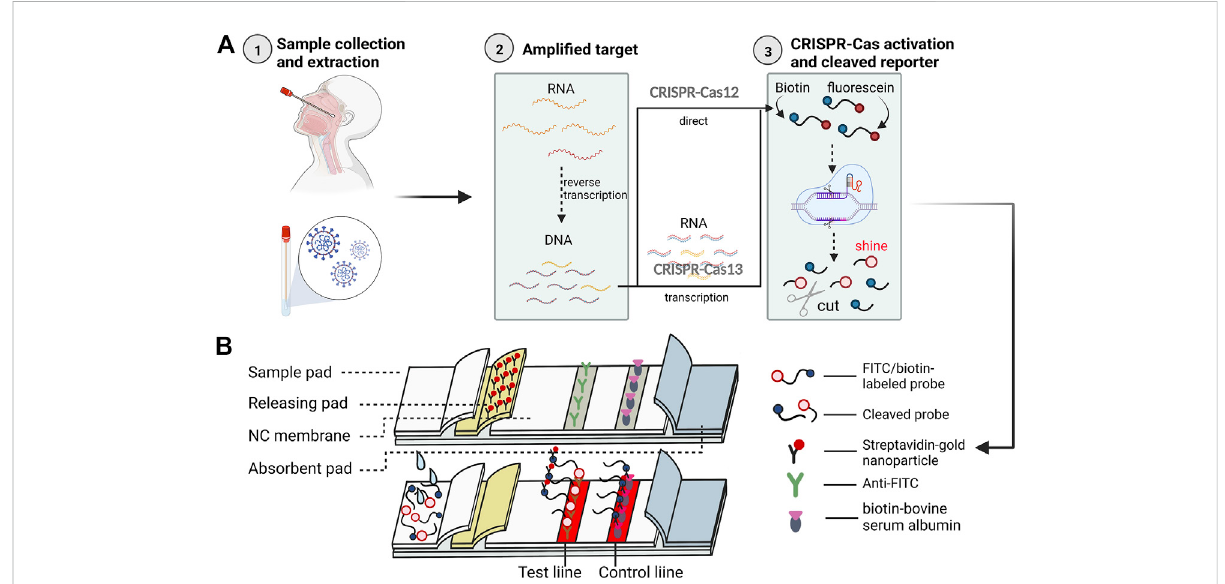
FIGURE 2 The CRISPR-Cas system for the whole process of COVID-19 immunochromatography detection. Illustrative scheme:The fi gure brie fl y summarizes thetechnical fl owofmostcurrentCRISPRcombinednucleicacidampli fi cationandLFIA usingthemethod designed byZhu etal. (2021) (A) In total,there arethree major stepsbefore usingimmunochromatographicteststrips. First,anasal orpharyngeal swabisused to collect asample from the subject and extract RNA. second, thenucleicacid is ampli fi ed, and the reverse transcription ampli fi cation method is generally chosen, inwhich theextracted RNAisspeci fi cally ampli fi edafter bindingto aprobe modi fi edwith a fl uorescentmoiety( fl uorescein)and aquenchingmoiety (biotin),duringwhichthetargetRNAisconvertedintoatargetformoreDNA.ThentheCRISPR-Cassystemisappliedtocutthetargetgenemotif,but because Cas12 and Cas13 cut RNA and DNA respectively, the nucleic acid also needs to be transcribed to RNA when Cas13 is selected. Third, the CRISPR-Cas system cuts and a probe with the target RNA or DNA bound to the Cas protein in advance is used to identify the target nucleic acid The CRISPR-Cas system isactivated whenthetargetnucleic acid,which has been modi fi edby fl uorescentand quenchingmotifs, binds totheprobeand cleaves the nucleic acid sequence non-selectively. The fi nal target nucleic acid sequence is cleaved and the fl uorophore fl uoresces, allowing the detectionofthesignal(RamachandranandSantiago,2021). (B) Theteststriplocatedatthetopisaschematicdiagramofthestructureoftheproduct, and the one at the bottom is presented after receiving a positive sample. The above processed products were transferred to LFIA strips for examination, and the cleaved and uncleaved nucleic acid fragments were fi rst labeled with colloidal gold and then fl owed to detection and quality control lines immobilized with anti-biotin and anti-luciferin antibodies, respectively, so that the aggregation of uncleaved nucleic acid fragments could show a red band, while the cleaved nucleic acid fragments could be detected by a fl uorescence detector. (This fi gure created with